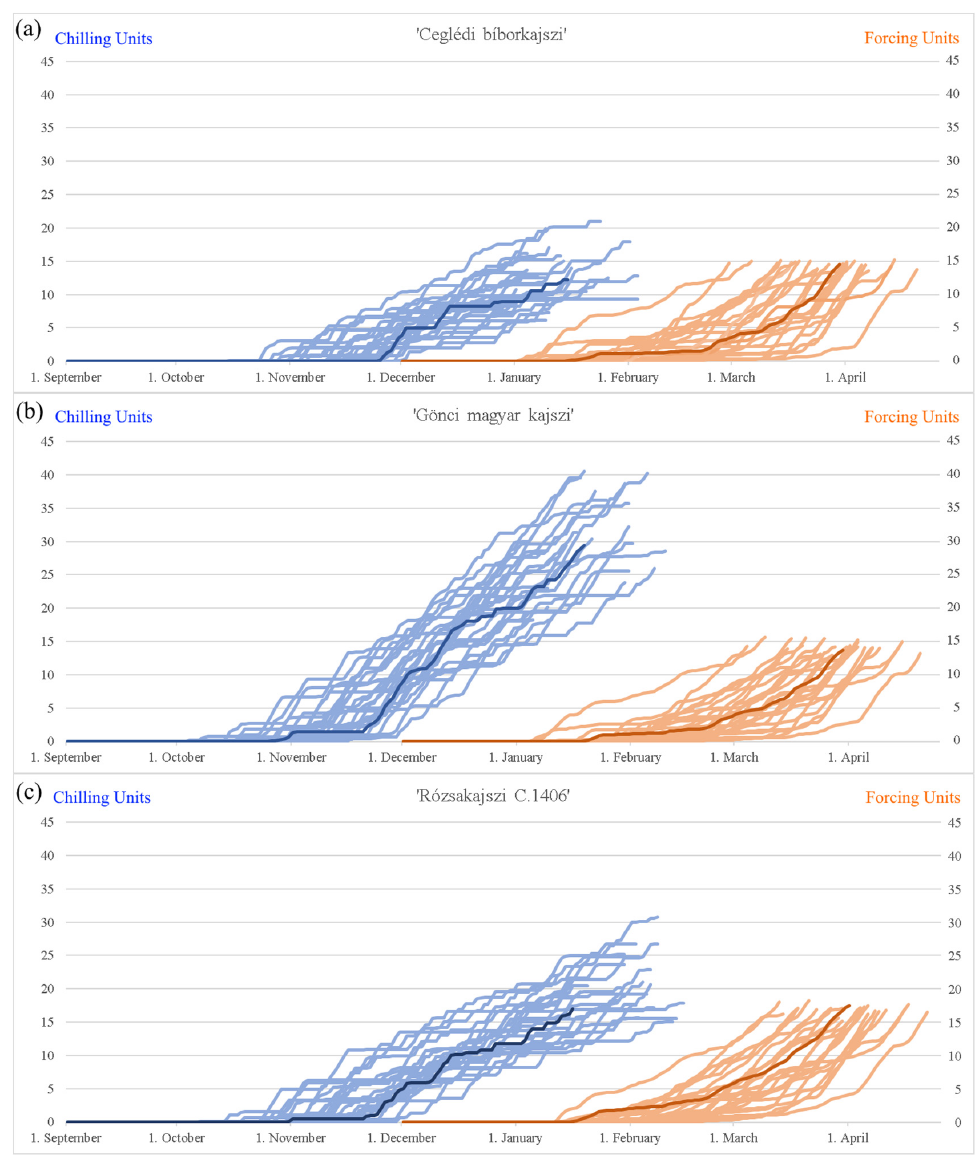
Figure 3. The annual chilling (blue curves) and forcing unit (orange curves) accumulation in the time period September 1994–April 2020 (highlighted: September 2014–April 2015 as a ‘pattern period’: this period has the lowest RMSE compared to the chilling units calculated from the mean daily temperatures of the twenty-six studied periods, i.e., the results of the year that can be considered as the most similar one to the ‘average year’) for ‘Ceglédi bíborkajszi’ ( a ), ‘Gönci magyar kajszi’ ( b ), and ‘Rózsakajszi C.1406 ′ ( c ).